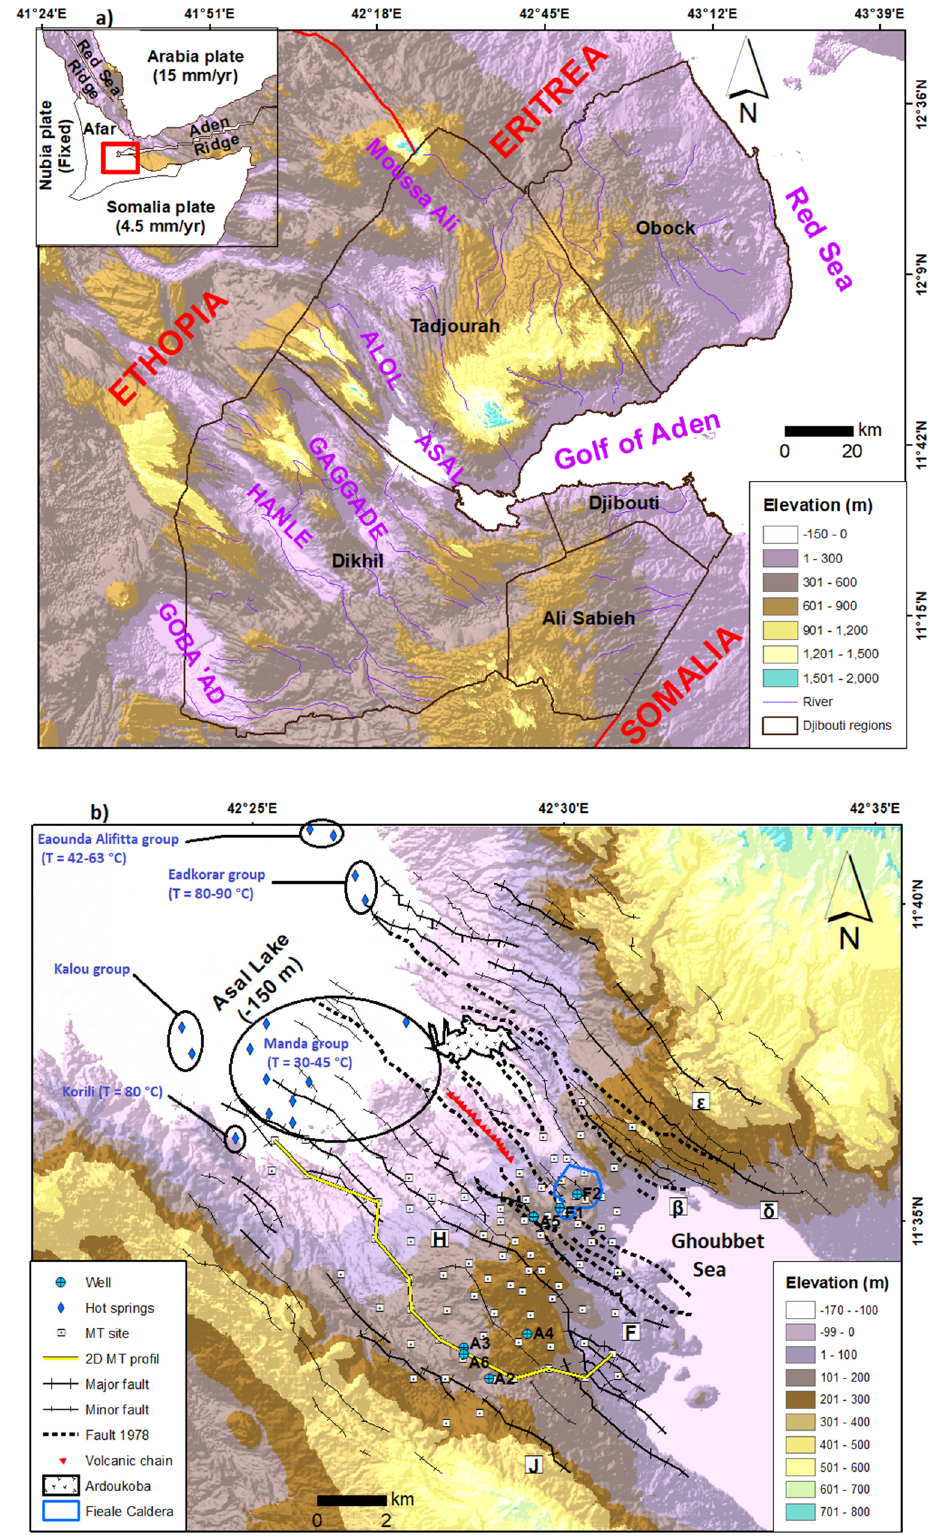
Figure 1. ( a ) Topographic map of Djibouti with the main geothermal potential sites. Red rectangle is Djibouti. ( b ) Structural map of the Asal Rift modified from [9]. EAR: East African Rift; MT: magnetotelluric.